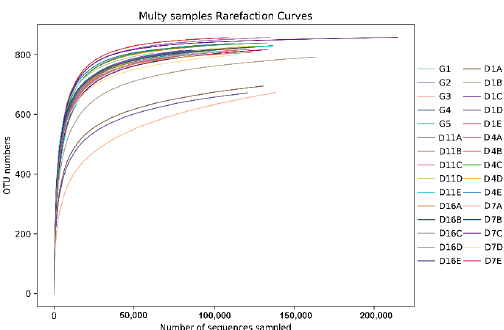
Figure 1. Rarefaction curves obtained by plotting the number of operational taxon units (OTUs) by number of reads for all fecal samples. The x -axis shows the number of valid sequences per sample and the y -axis shows the number of observed species (in OTUs).